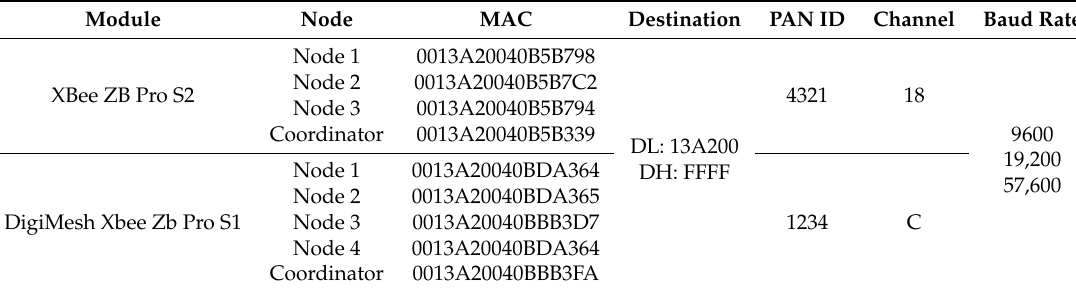
Table 4. Configuration parameters for the communication modules.